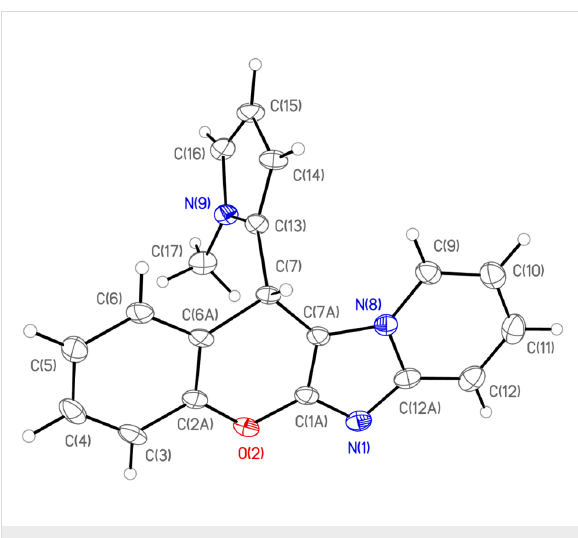
Figure 2: General view of the molecule 7b in the crystal state (CCDC 1849215). Anisotropic displacement parameters are drawn at 50%